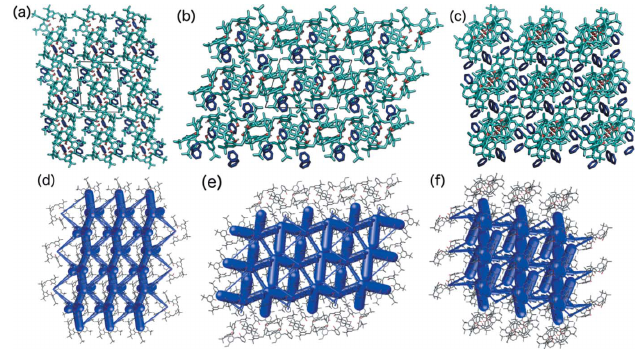
Figure 5 ( a )–( c ) Packing diagrams and ( d )–( f ) crystal structure frameworks of 1 , viewed along the [100], [001] and [110] axes from left to right,